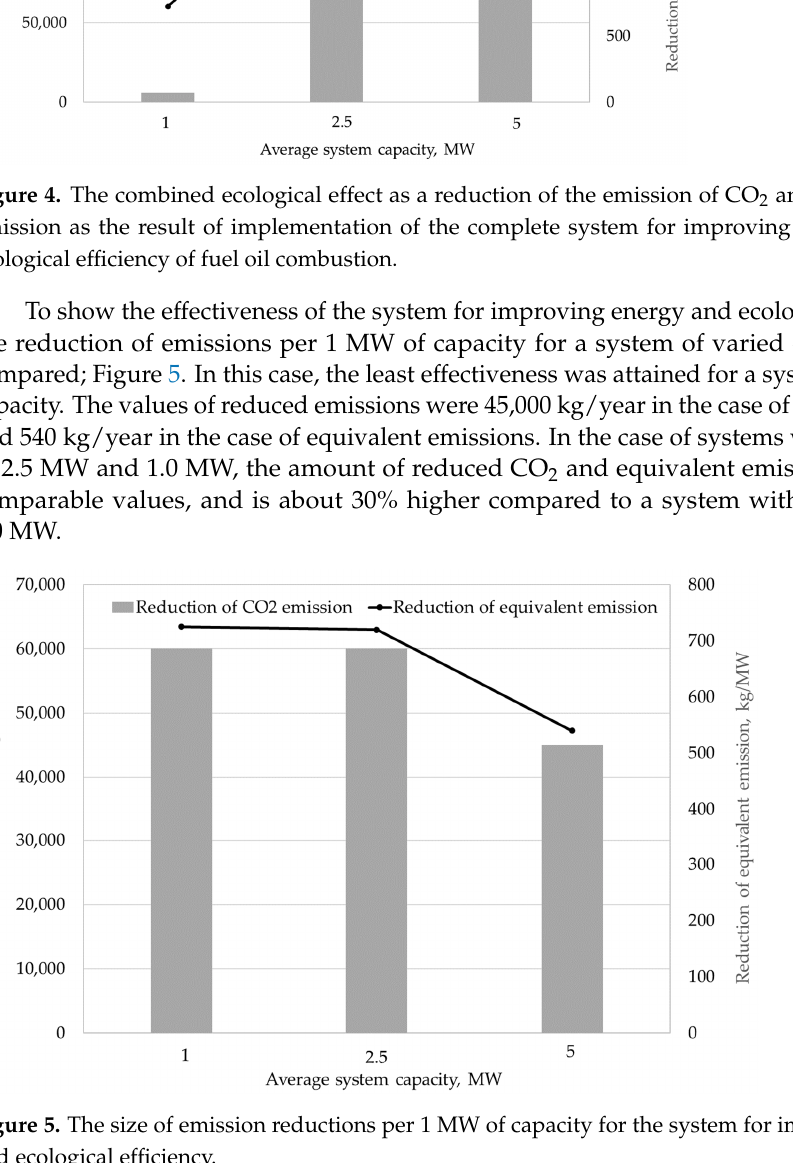
Figure 6. CO 2 emission in fuel oil combustion for system capacities from 1 MW to 5 MW.